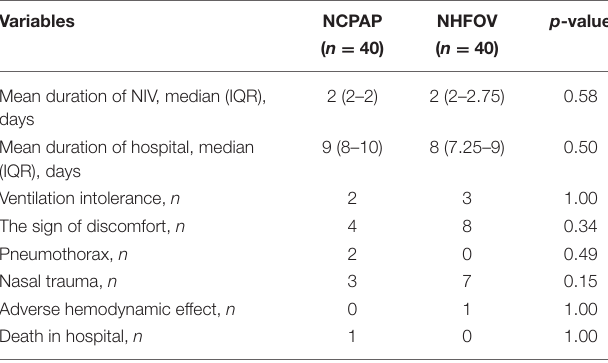
TABLE 3 | The secondary outcomes between NCPAP treatment and NHFOV treatment.